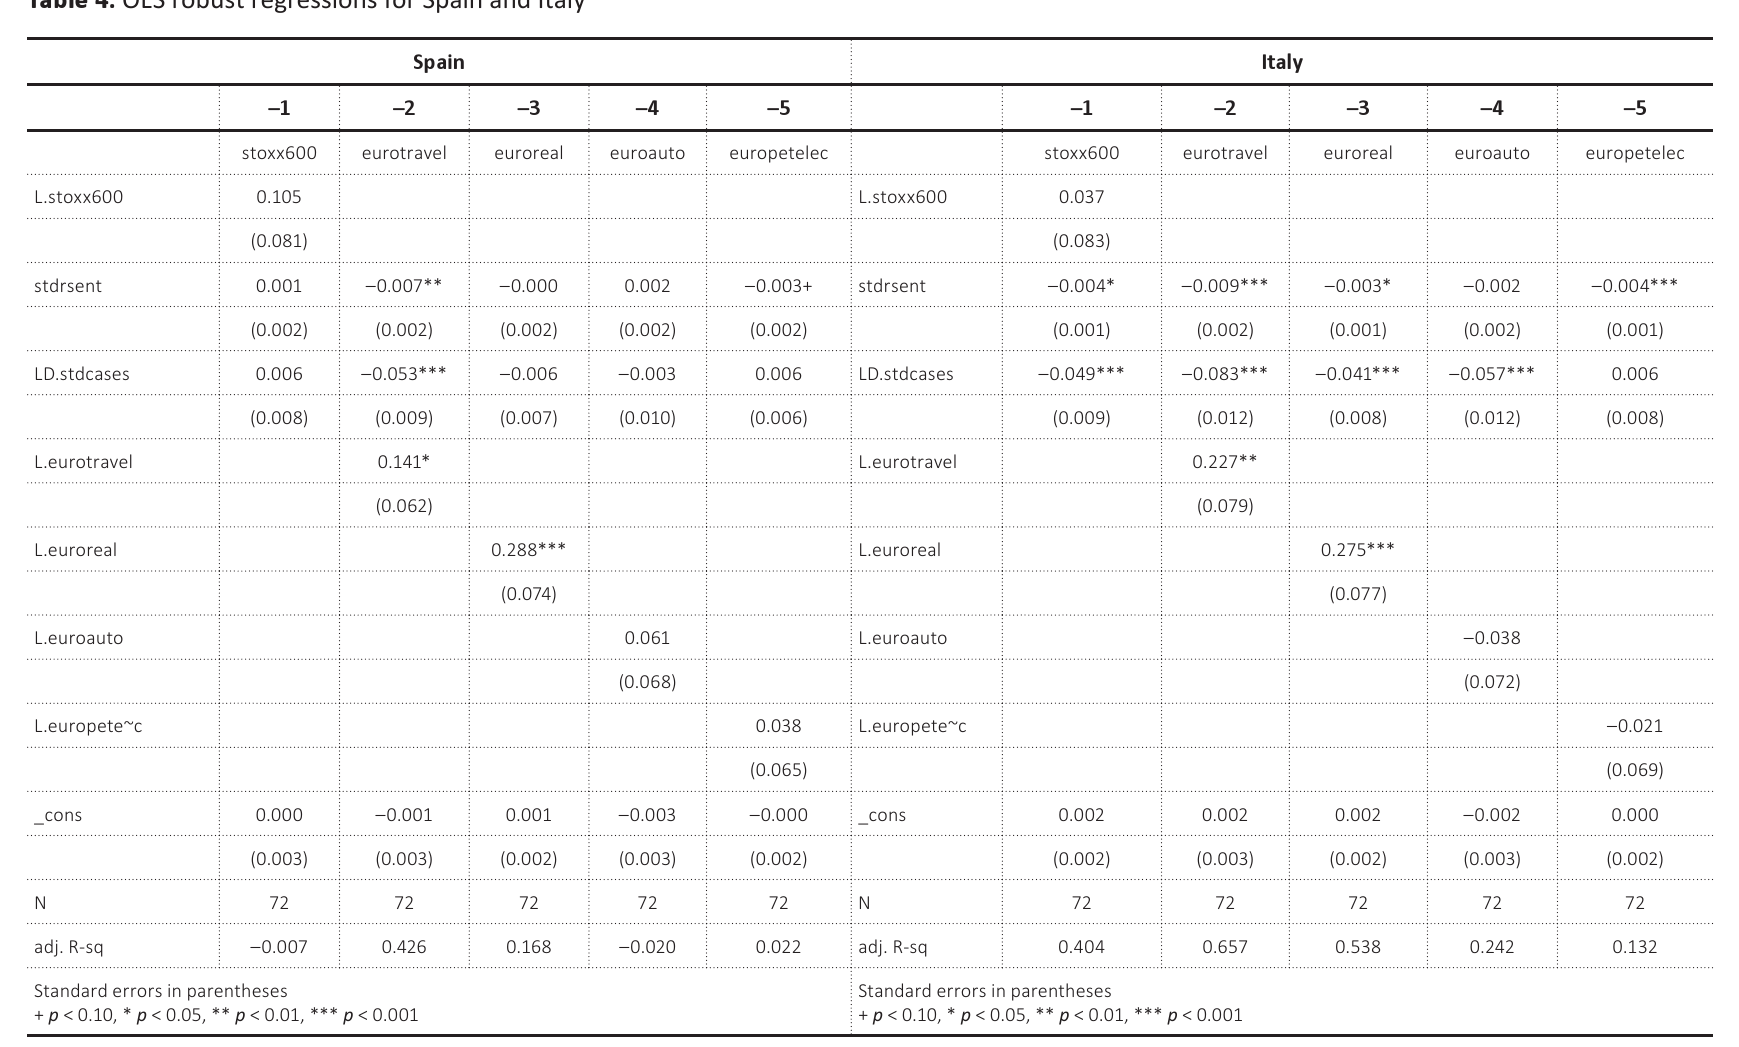
Note: Table 4 reports the influence of standardized sentiment index and standardized first lagged difference of COVID-19 cases on global and sector return indexes or ETFs. Spain’s tourism returns are affected by real cases, and Italy is more rationally affected globally in tourism, real estate, and auto